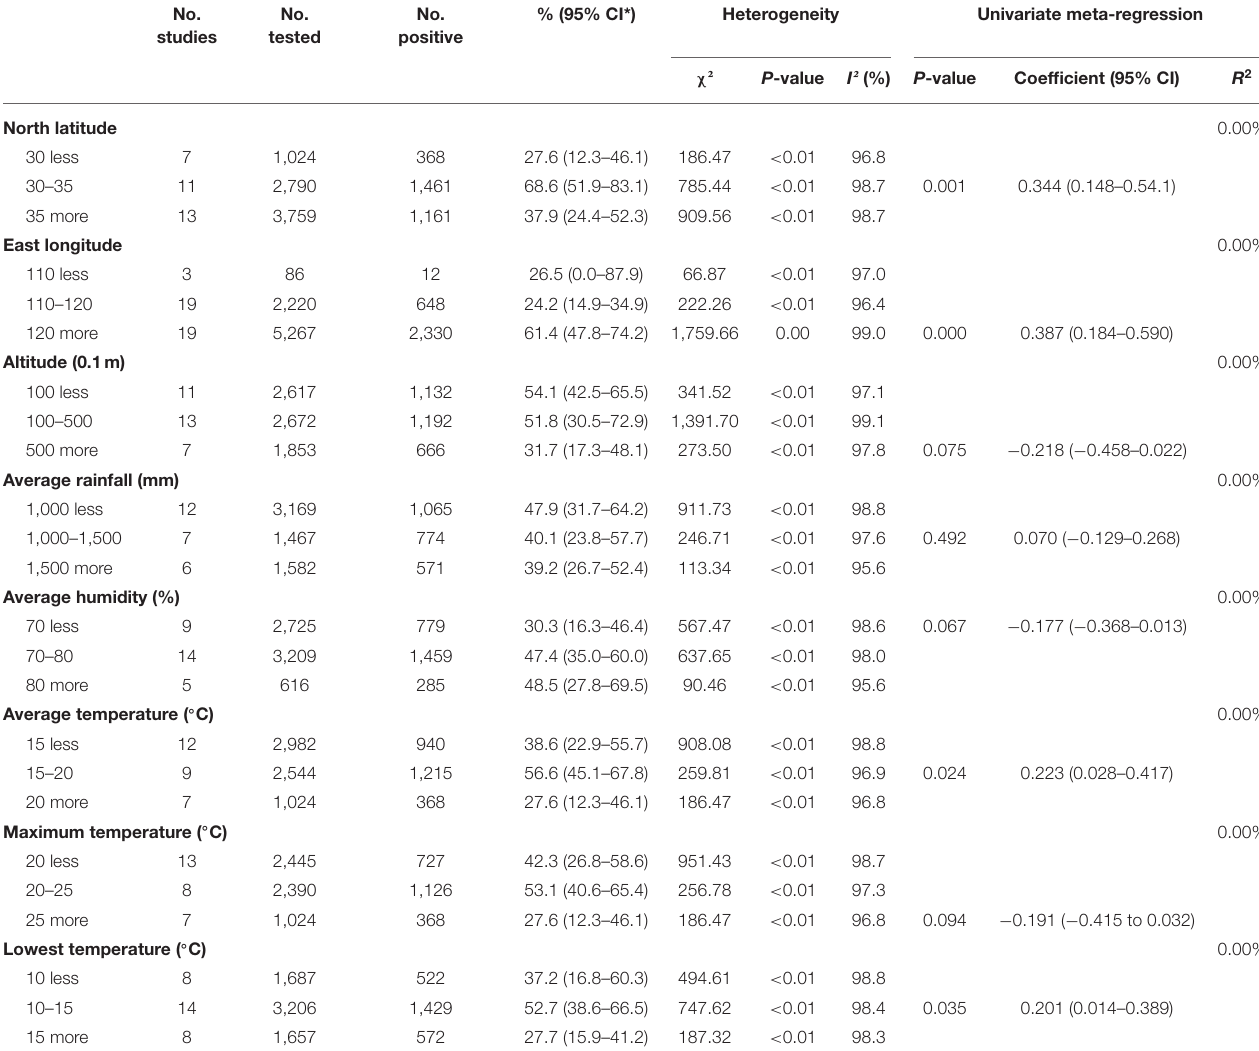
TABLE 7 | Pooled prevalence of geographical